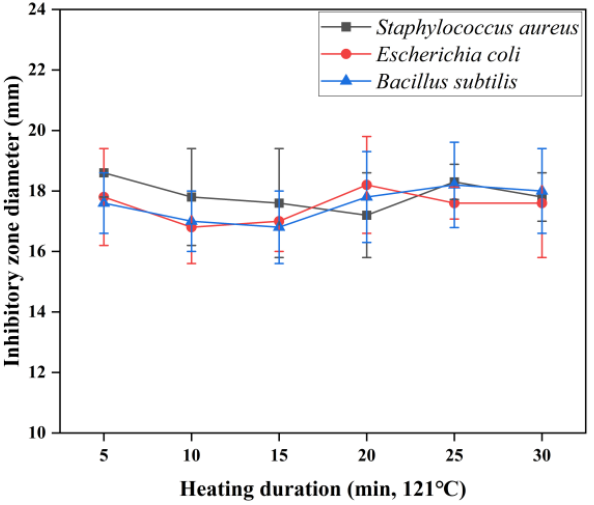
Figure 8. The impact of heating on the bacteriostatic effect of greengage fermentation waste. The data are shown as the mean values of three determinations (n = 3) ± standard deviation (error bars).